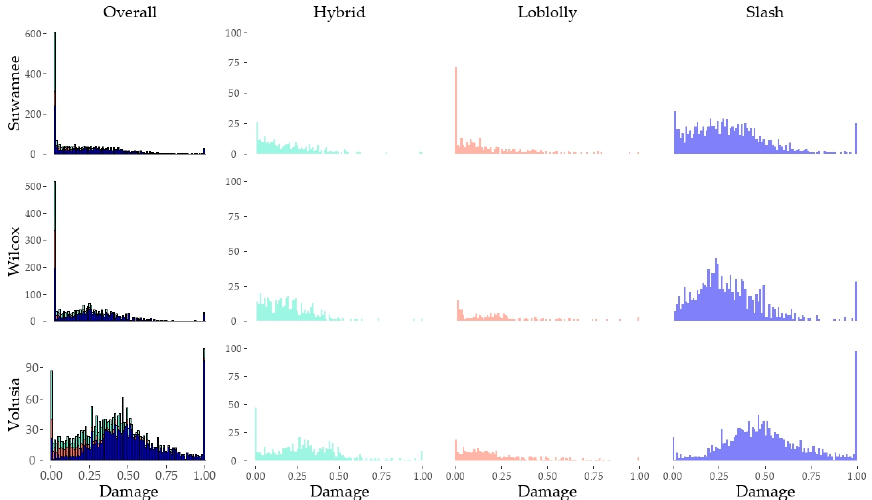
Figure 4. Histogram of percent stem damage on individual trees stratified by isolate, including rec- ords identified as potential escapes. Figure 4. Histograms of percent stem damage on individual trees stratified by isolate. The complete set of records (including all taxa) are seen in the first column. Records are stratified by taxa in the second (hybrid slash × P. caribaea ), third ( P. taeda ), and fourth ( P. elliottii var. elliottii ) columns. These histograms include all data including records identified as potential escapes. Table 1. Average damage ratios stratified by taxon and isolate for full and reduced data